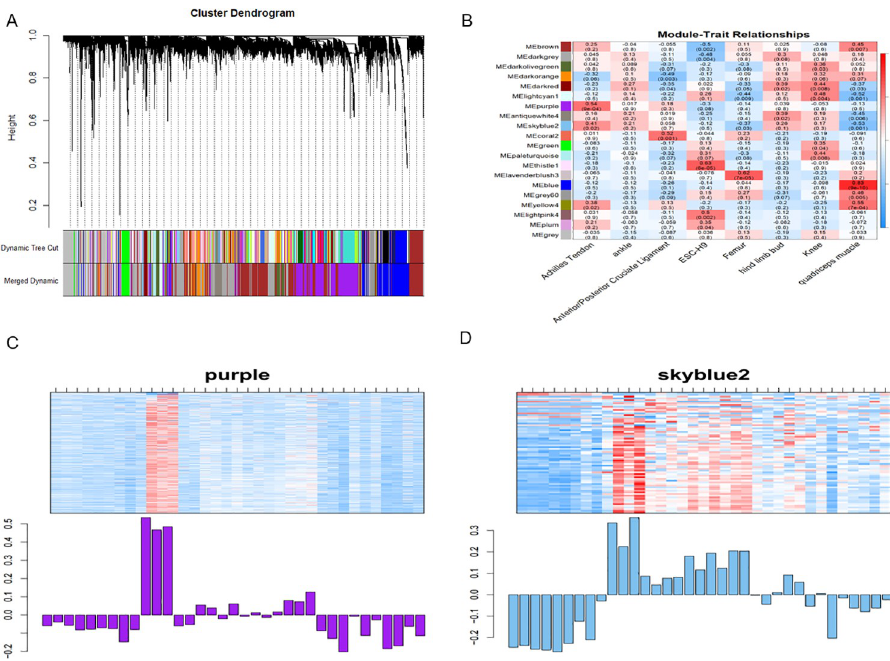
Fig 4. The WGCNA analysis of GSE106292 data set. (A)Tree of all gene expressions based on the Difference Measure (1-TOM) cluster (B)The heat maps of correlations between modules feature genes and samples, with each cell containing correlation coefficients and P values (C)The expression calorimetry and feature vector histogram of PURPRE module (D)The expression calorimetry and feature vector histogram of Skyblue2